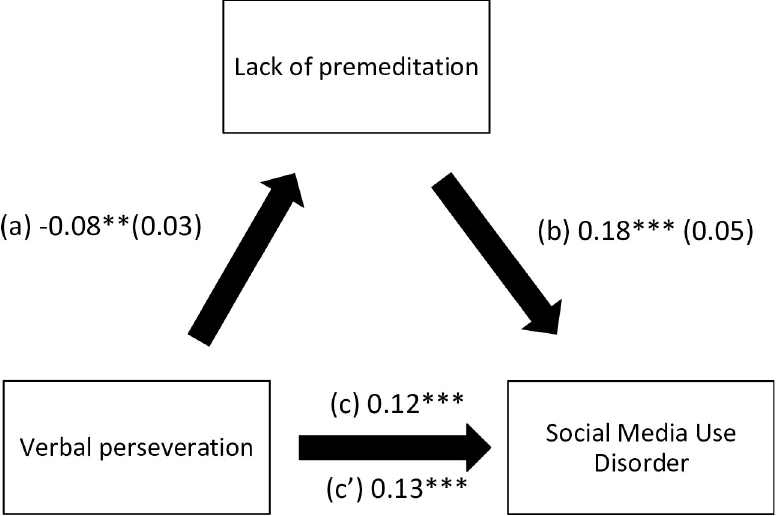
Fig 2. (a) Relation between verbal perseveration and lack of premeditation (R 2 = 20.38%); (b) Relation between lack of premeditation and social media use disorder (R 2 = 13.92%); (c) Total effect of the relation between verbal perseveration and social media use disorder (R 2 = 9.55%); (c’) Direct effect of the relation between verbal perseveration and social media use disorder. Numbers are displayed as regression coefficients (standard error). ��� p < 0.001; � p < 0.05.